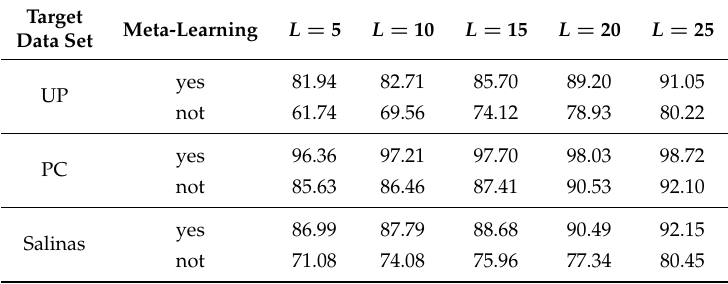
Table 12. Influence of the meta-learning phase on classification accuracy (OA, %). L is the number of labeled samples per class.